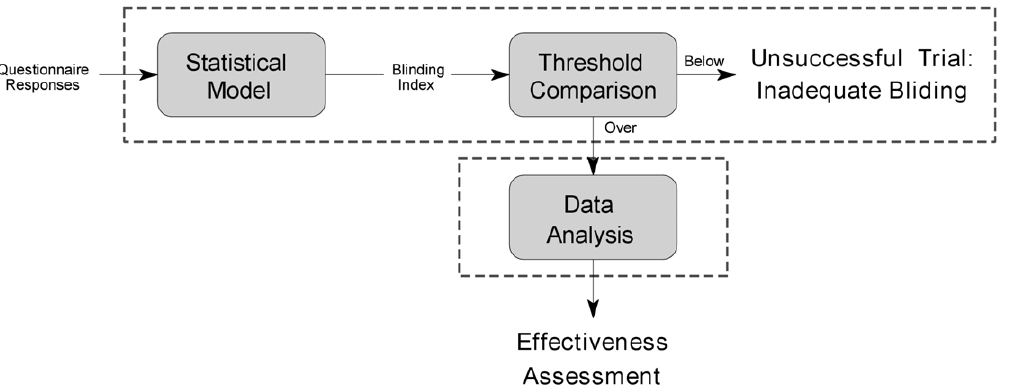
Figure 2. The current clinical practice separates the task of assessing the degree of blinding in a trial from the comparative analysis of the effectiveness of different interventions studied. The effectiveness of the treatment of interest is only analyzed if the trial is first deemed to have been sufficiently blinded. In contrast, the proposed methodology concurrently employs all available information. By doing this, our approach is able to deal with the entire continuum of different levels of blinding, never discarding